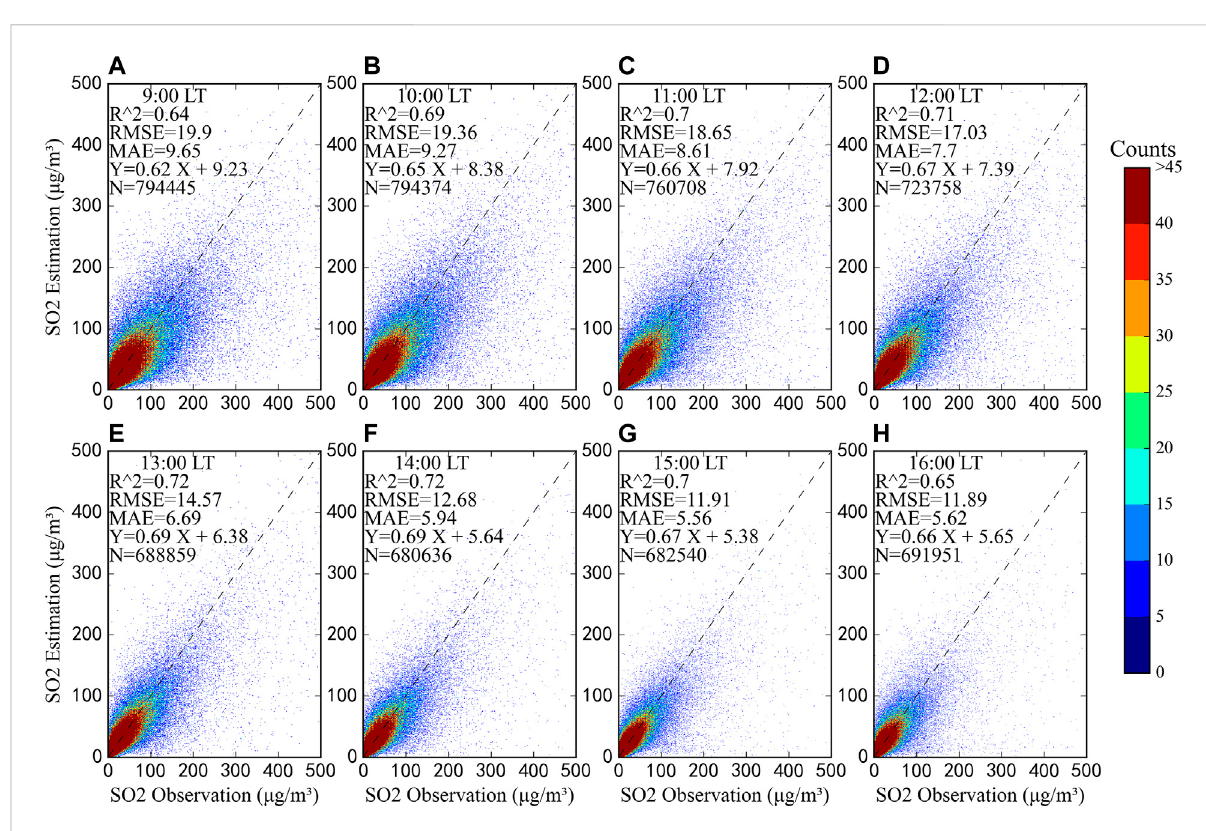
FIGURE 3 Hourlymodel10-foldcrossvalidationresultsbasedonsamples,whichthelightdashedlineistheperfectly fi ttedline,thatis,the1:1relationship, LT represents Beijing time, and N represents the total sample